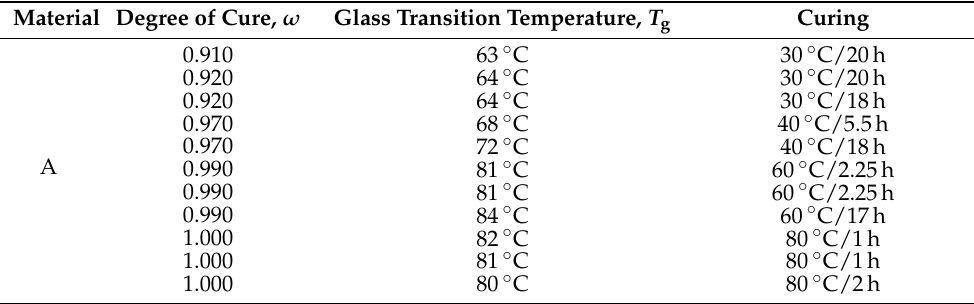
Table 1. Curing and post-curing protocols for the definition of the five curing degrees for materials A and B. Material Degree of Cure, ω Glass Transition Temperature, T g Curing